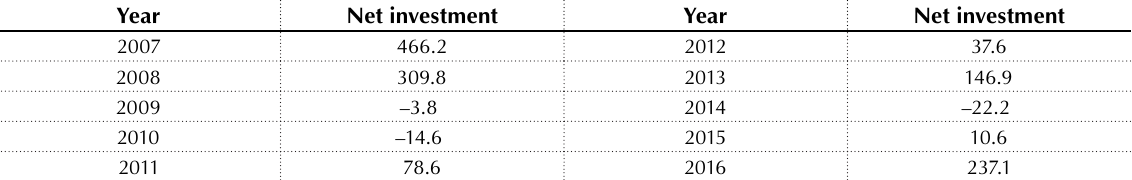
Source: ASE annual report, various